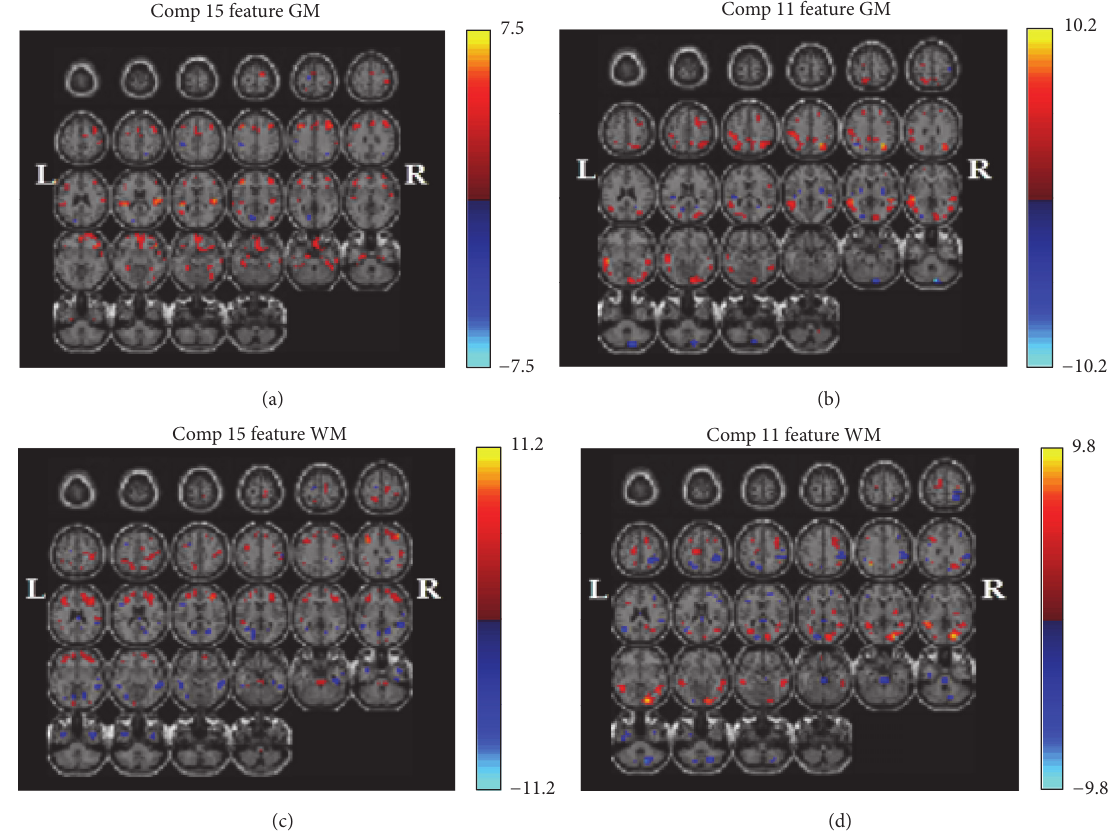
Figure 1: Significance maps with schizophrenia and normal. Those maps illustrating covariant decreases in the grey and white matter volume in patients with schizophrenia compared with normal controls for 𝑝 < 0.003333 : Component 15 of the grey matter (GM) (a), Component 15 of the white matter (WM) (c), Component 11 of GM (b), and Component 11 of WM (d). The left of the plane is the left side of the brain. The color represents the level of correlation: deeper red represents higher level of positive correlation, while deeper blue represents higher level of negative